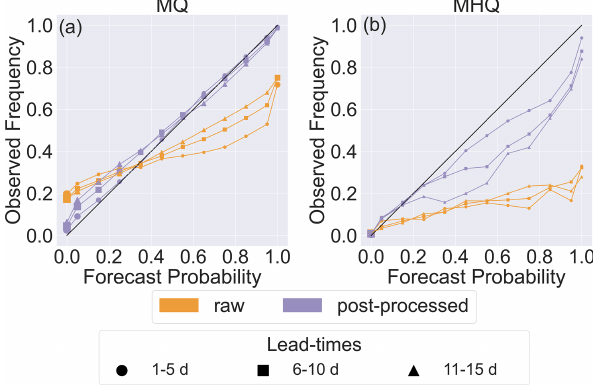
Figure 8. Reliability diagrams for (a) the MQ and (b) the MHQ. All stations are combined and groupings of lead times are used (see Sect.